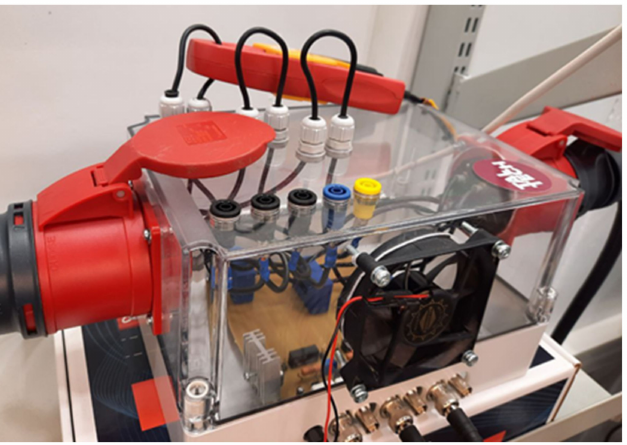
Figure 5. The current LEM current transducers PCB and FLUKE current clamp